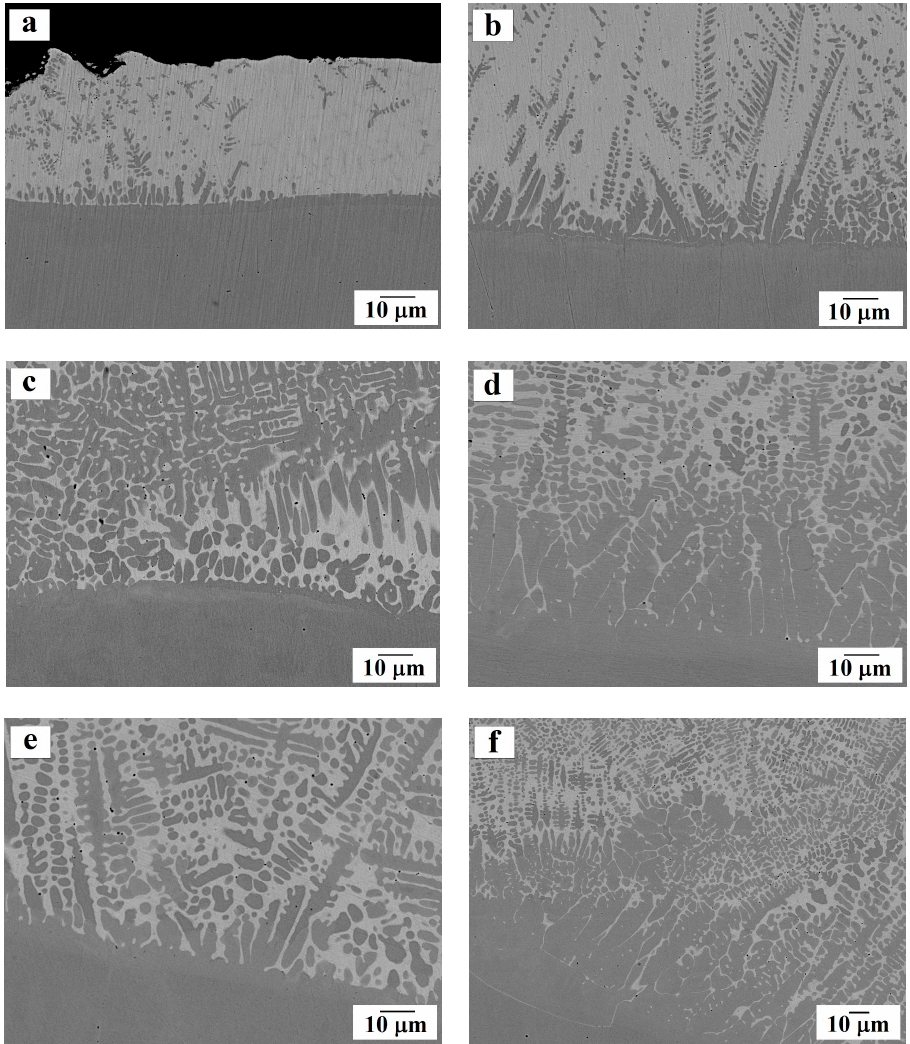
Figure 4. The microstructure of the substrate-coating contact zone (according to SEM data). Magnified fragments for samples: ( a ) No. 1; ( b ) No. 2; ( c ) No. 3; ( d ) No. 4; ( e ) and ( f ) No. 5.